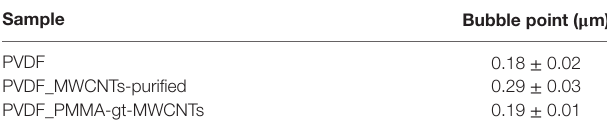
TaBle 4 | Bubble point values for PVDF